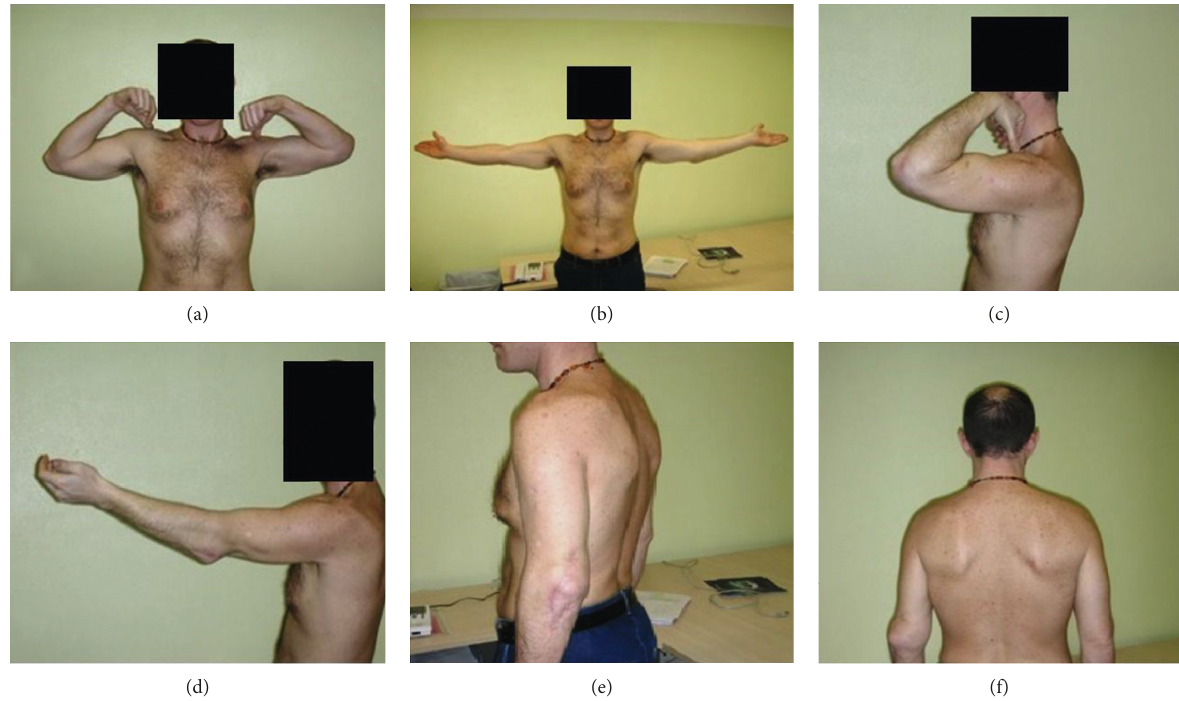
Figure 5: Final postoperateive situation at 5 years of follow-up (a–d). Valgus axial deviation (e,